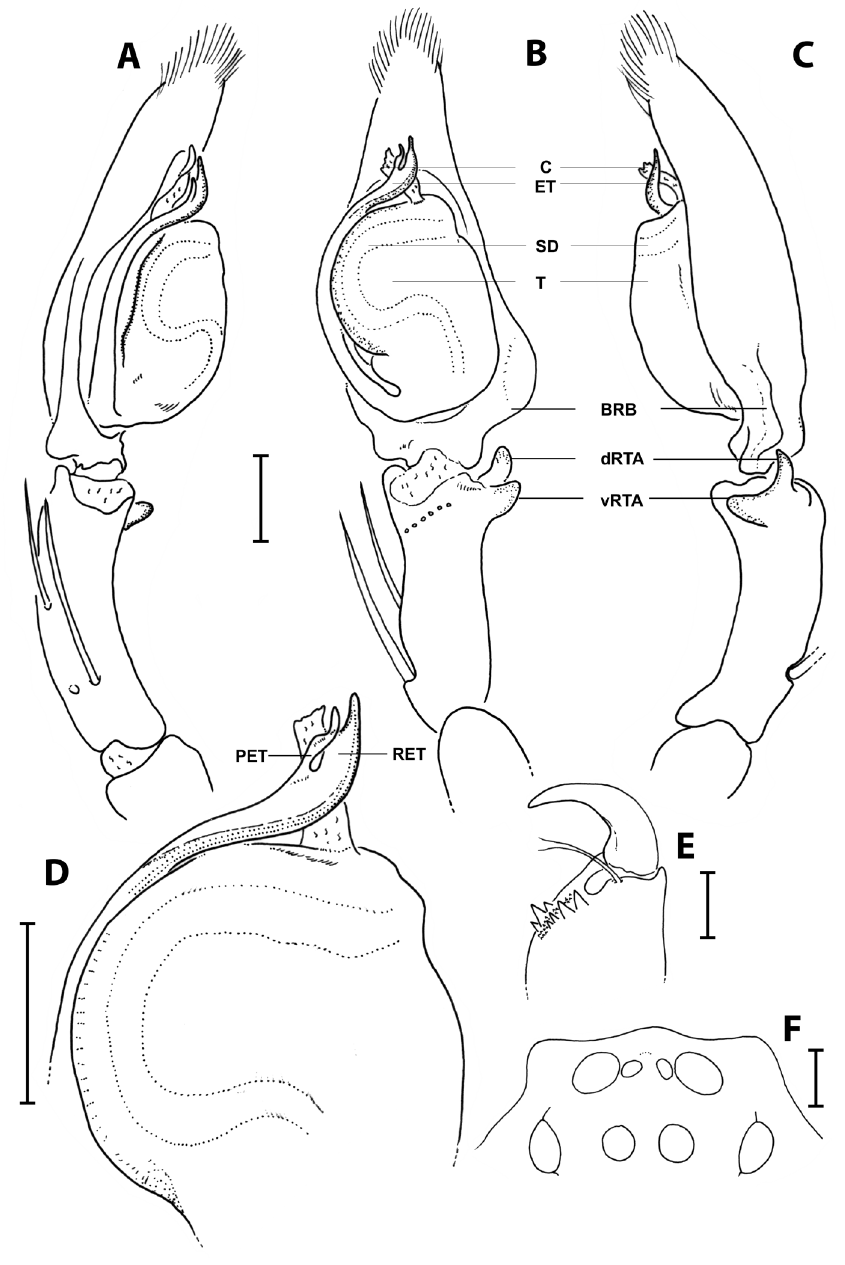
Figure 1. Spariolenus fathpouri sp. n., male holotype, Khuzestan, Pebdeh Cave, Iran (SMF). A–C left palp ( A prolateral B ventral C retrolateral) D bulbus, ventral E chelicerae, ventral F eye arrangement, dorsal. Abbreviations: BRB – basal retrolateral bulge, C – conductor, ET – embolus tip, PET – prolateral part of embolus, RET – retrolateral part of embolus, RTA – retrolateral tibial apophysis, SD – sperm duct, T – tegulum. Scale bars: 1 mm ( A–C, E, F ), 0.5 mm ( D